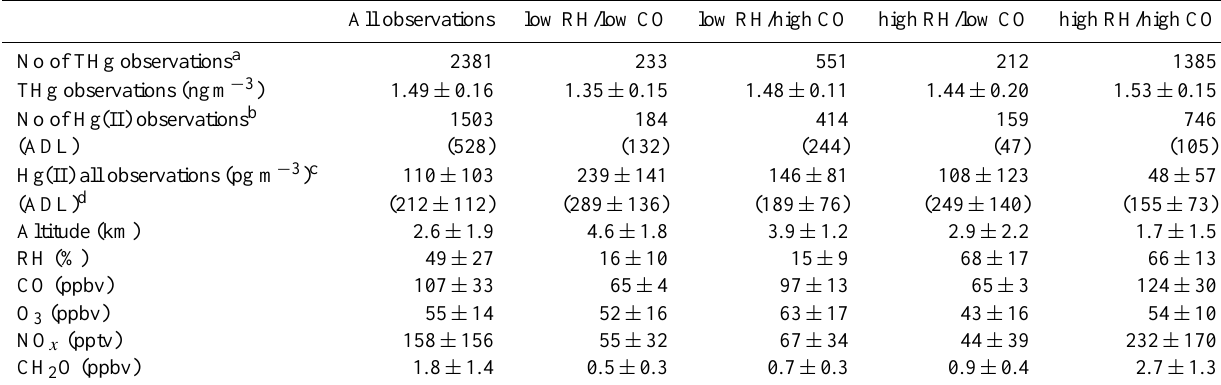
Table 3. Chemical characteristics of NOMADSS observations classified in four air mass categories.